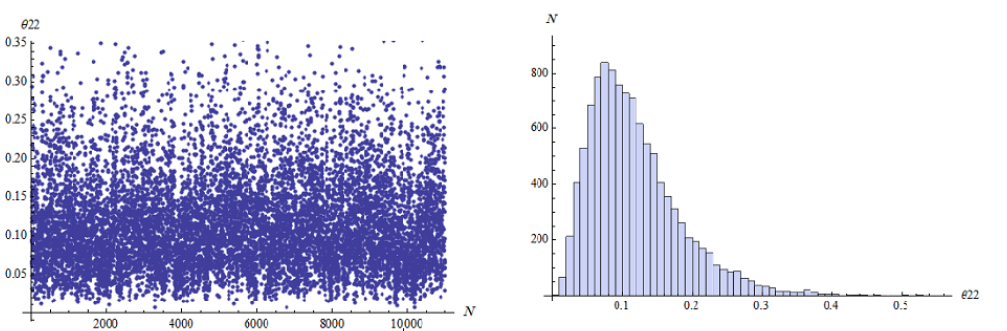
Figure 4. Trace ( Left ) and histogram ( Right ) plots of the parameter θ 21 .